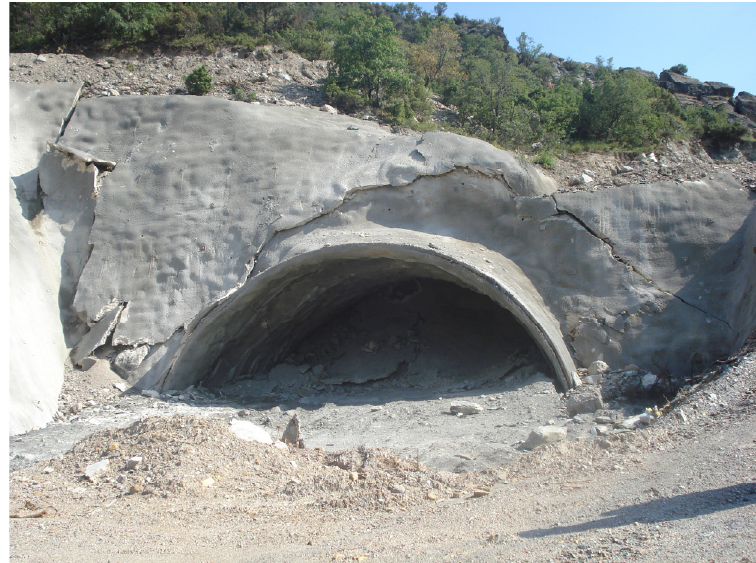
Figure 5. The entrance portal of the T26 tunnel abandoned in 2009 [36].